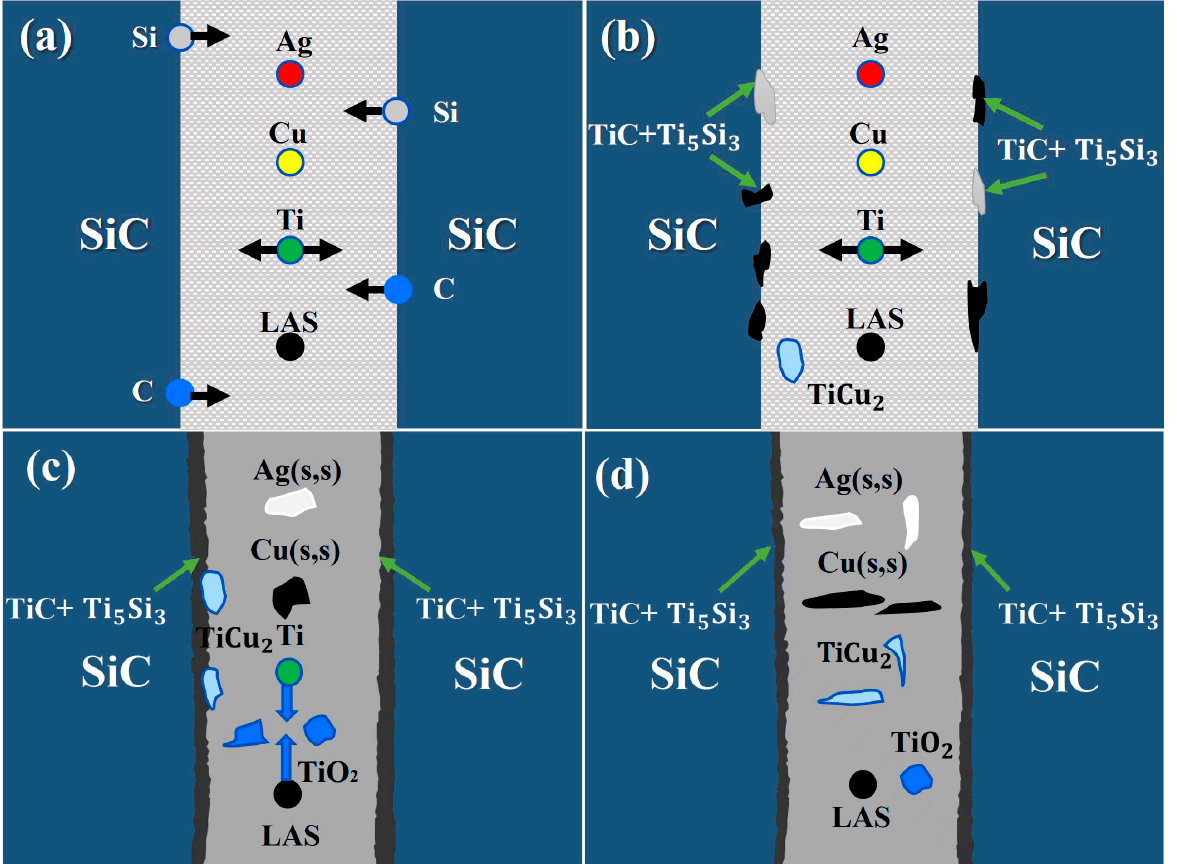
Figure 8. Schematic diagram of the microstructure evolution of SiC brazed joints. ( a ) solid phase diffusion during the physical contact stage, ( b ) atomic diffusion during melting of filler metal, ( c ) interface reaction during heat preservation, ( d ) products formation after cooling.